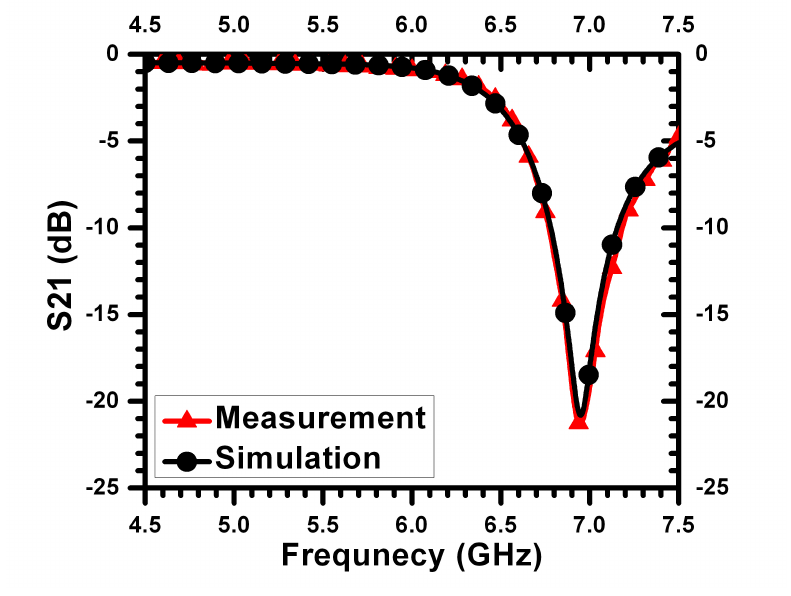
Figure 2.3: Minimum transmission of the sensor obtained from full-wave solver HFSS and measurement of the sensor in case without a